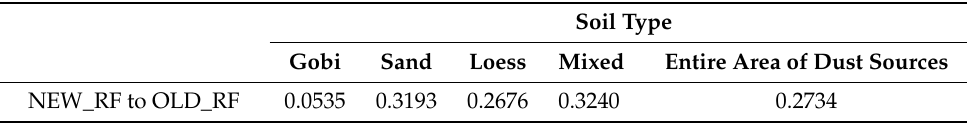
Table 1. Mean RF differences between the NEW_RF and OLD_RF over the areas with the specified soil types separately, as well as over the entire area of Asian dust sources during spring 2017.